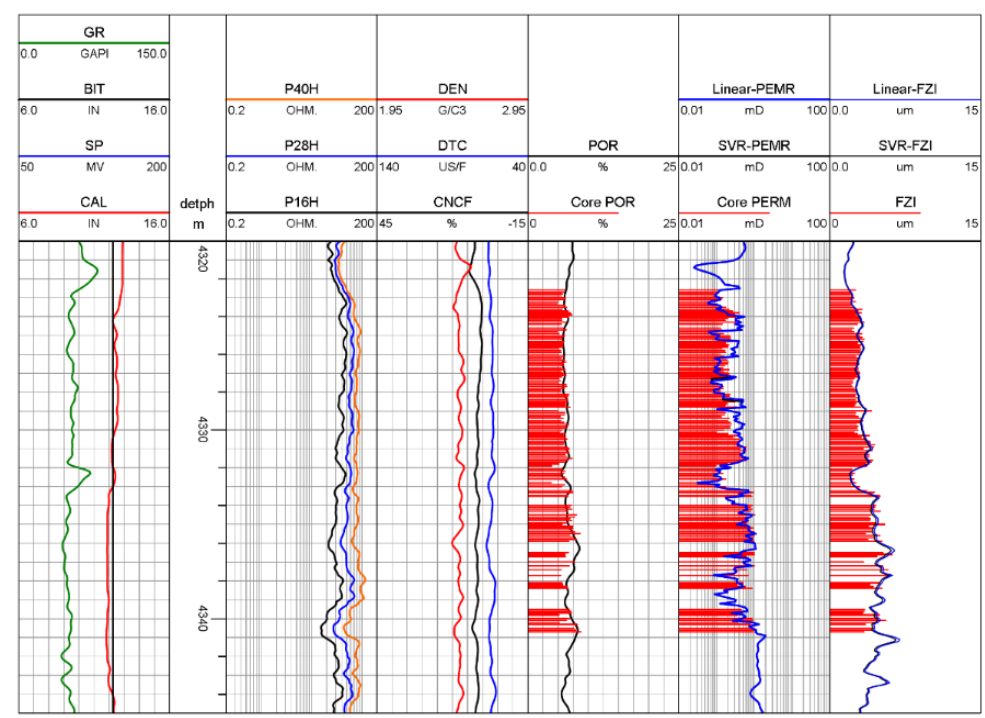
Figure 9. The conventional logging response diagram of the 4320–4345 m well section of Well X1.